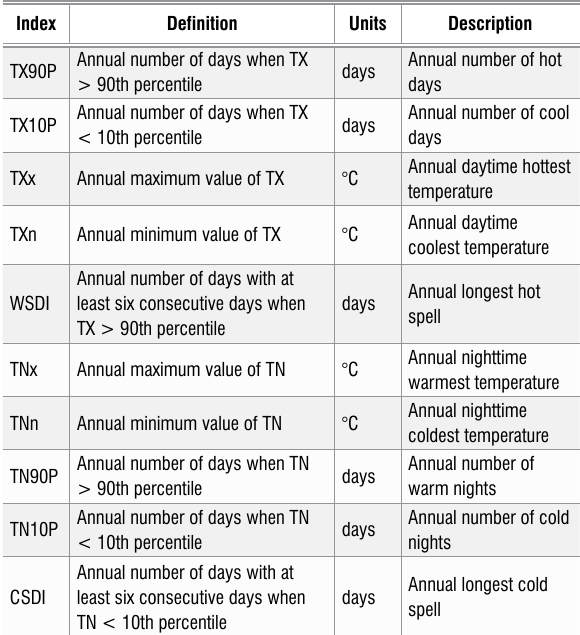
Relevant extreme temperature indices, developed by the World Meteorological Organization’s Expert Team on Climate Change Detection and Indices, use in this